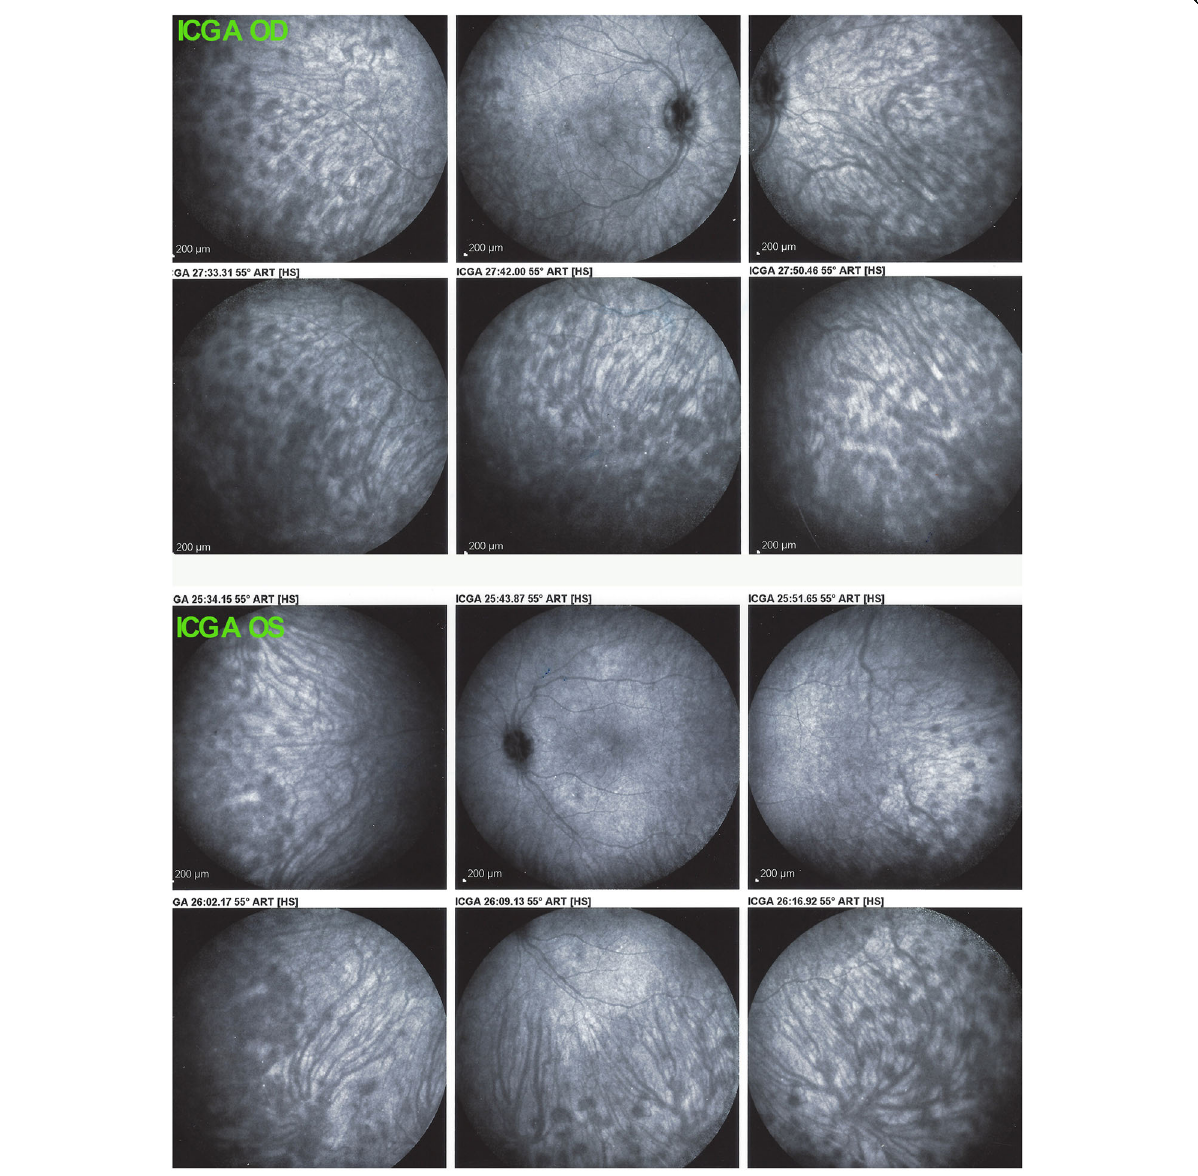
Fig. 3 ICGA ODS of VKH patient at the time of prednisone discontinuation. ICGA shows re-apparition of HDDs at the moment of prednisone discontinuation, despite mycophenolic acid and cyclosporine therapy that led to the introduction of infliximab